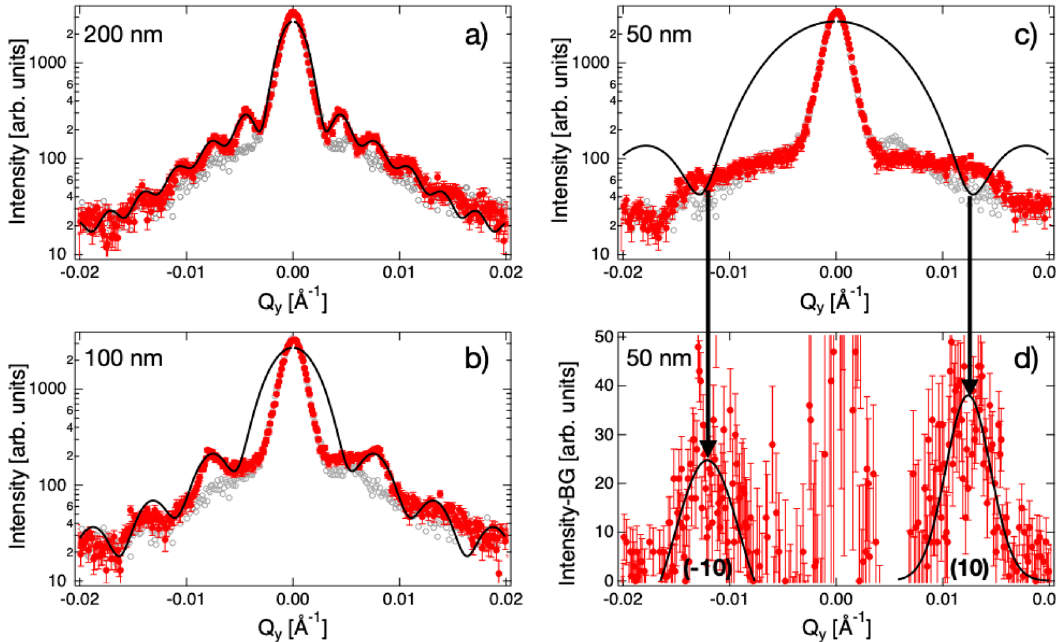
Figure 4. π-GISANS data taken on Super ADAM with silica particles, of size 200 nm ( a ), 100 nm ( b ) and 50 nm ( c , d ), deposited on a silicon wafer and shown as red circles. The grey open circles symbolise a measurement performed with a bare silicon substrate. The solid black lines represent simulations of the form ( a , b , c ) and structure factor ( d ) of the particles.